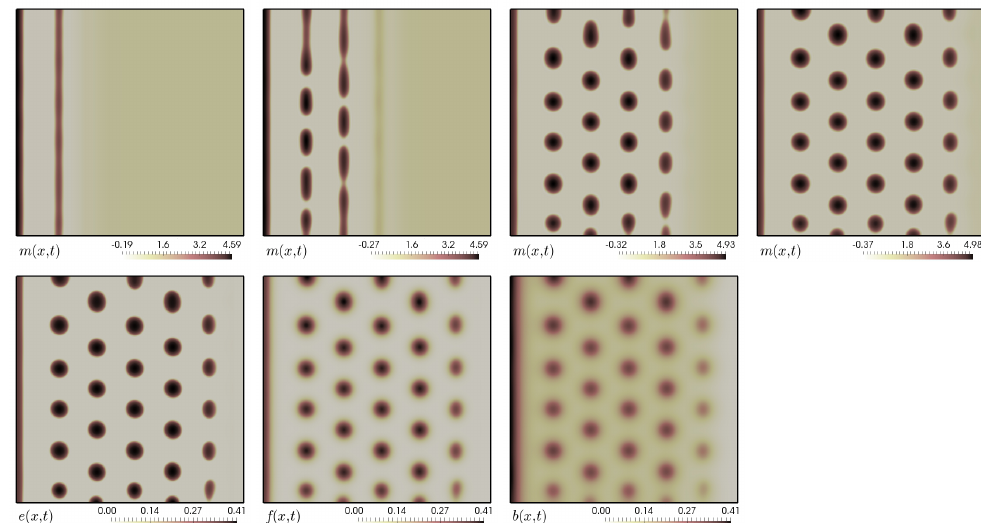
Figure 5. Evolution of the mesenchymal cell concentration at t = 160,280,400,520, under no deformation ( top panels); and epithelium, FGF, and BMP concentrations at t = 520 ( bottom ).